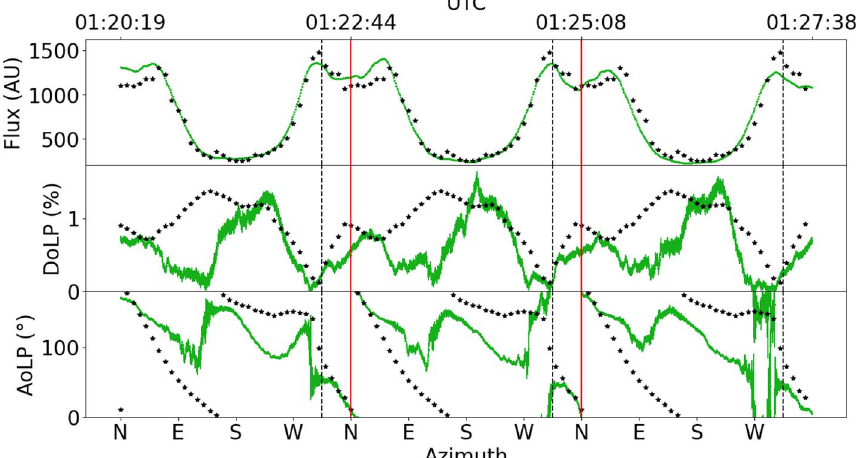
Fig. 11. 3 almucantar observations at 557.7±5 nm (March 8, 2019): observations (in green) and predictions for the model that best fi ts the data (Black stars H ). The model is a linear combination of ground and sky (including albedo) for a 1.3% polarised sky emission in a direction de fi ned by an azimuth of 35 (cid:3) and (cid:3) 3 (cid:3) elevation (see text for details). The dashed vertical black line indicates the direction of Skibotn. The picture of the sky at 557.7 nm is shown in Appendix